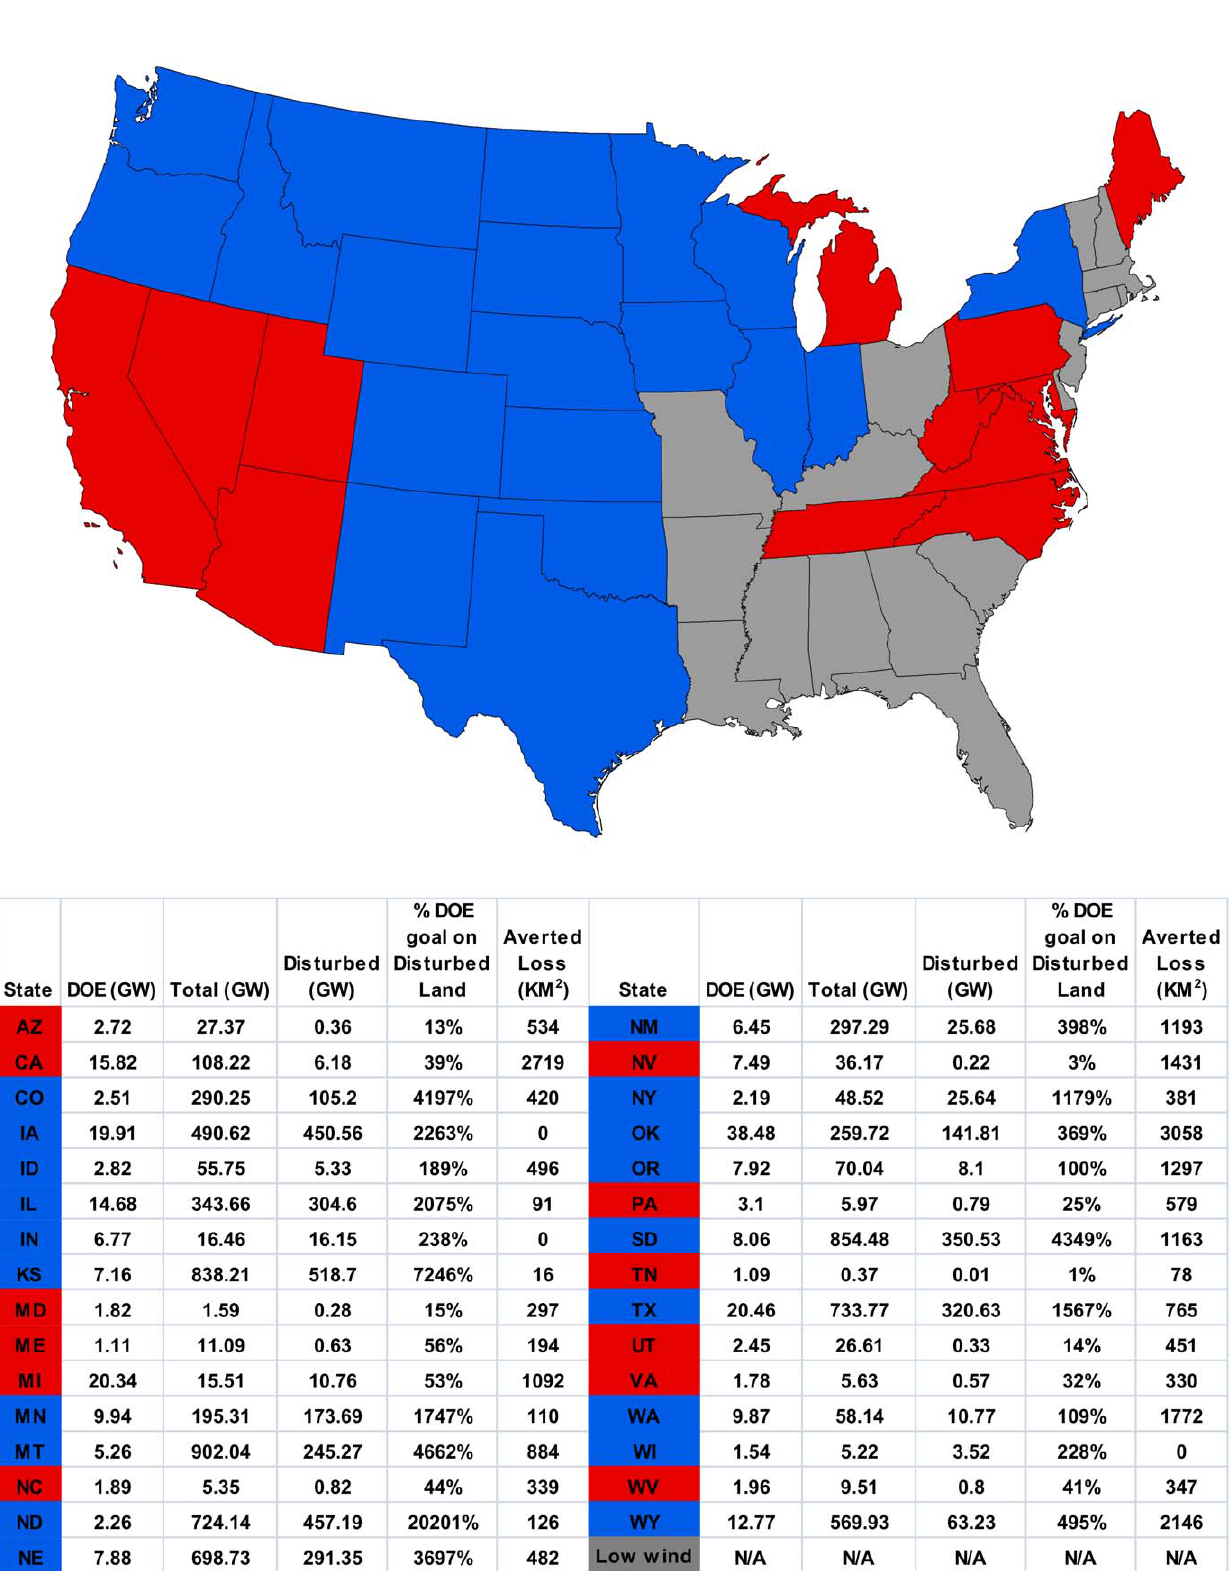
PLoS ONE | www.plosone.org